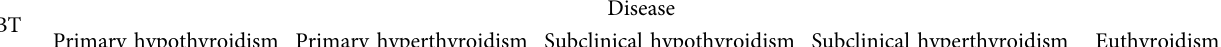
Table 5: Prevalence of mean ± SD values of thyroid dysfunction in kidney